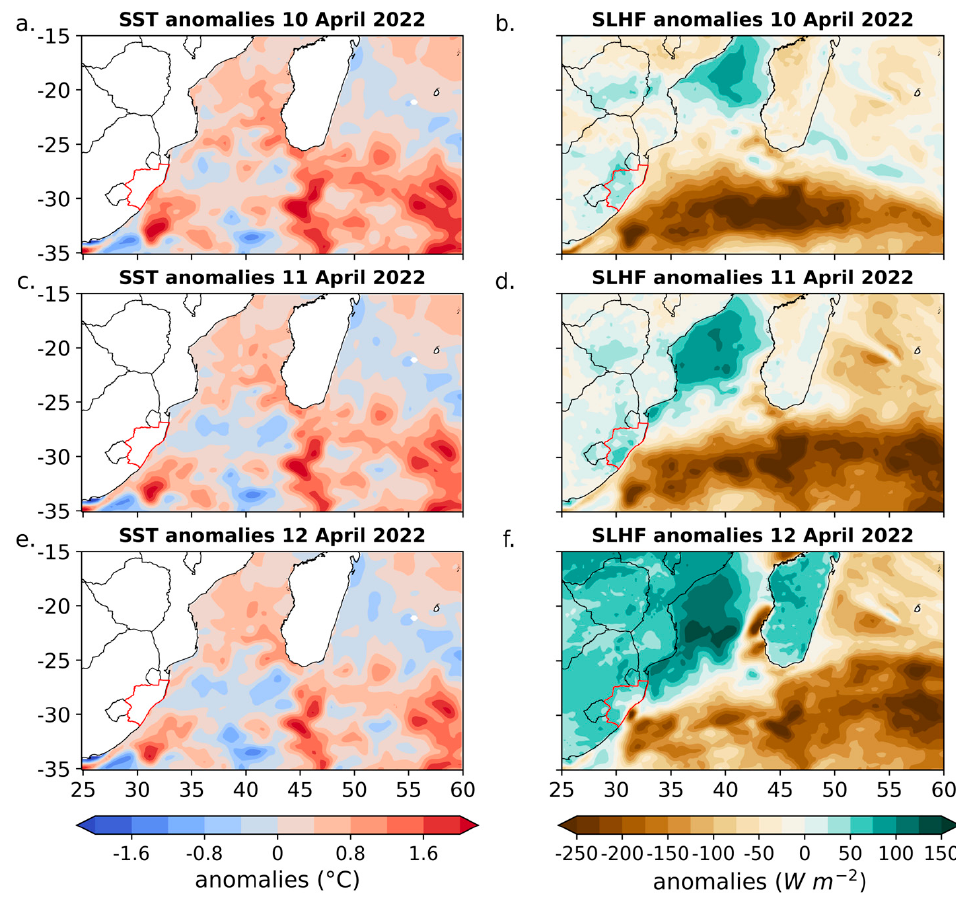
Figure 9. Sea surface temperature anomalies (shaded; °C) from NOAA OISSTv2 data for ( a ) 10 April; ( c ) 11 April and ( e ) 12 April 2022. Similarly, ERA5 surface latent heat flux anomalies (shaded; W m − 2 ) averaged over ( b ) 10 April; ( d ) 11 April and ( f ) 12 April 2022.